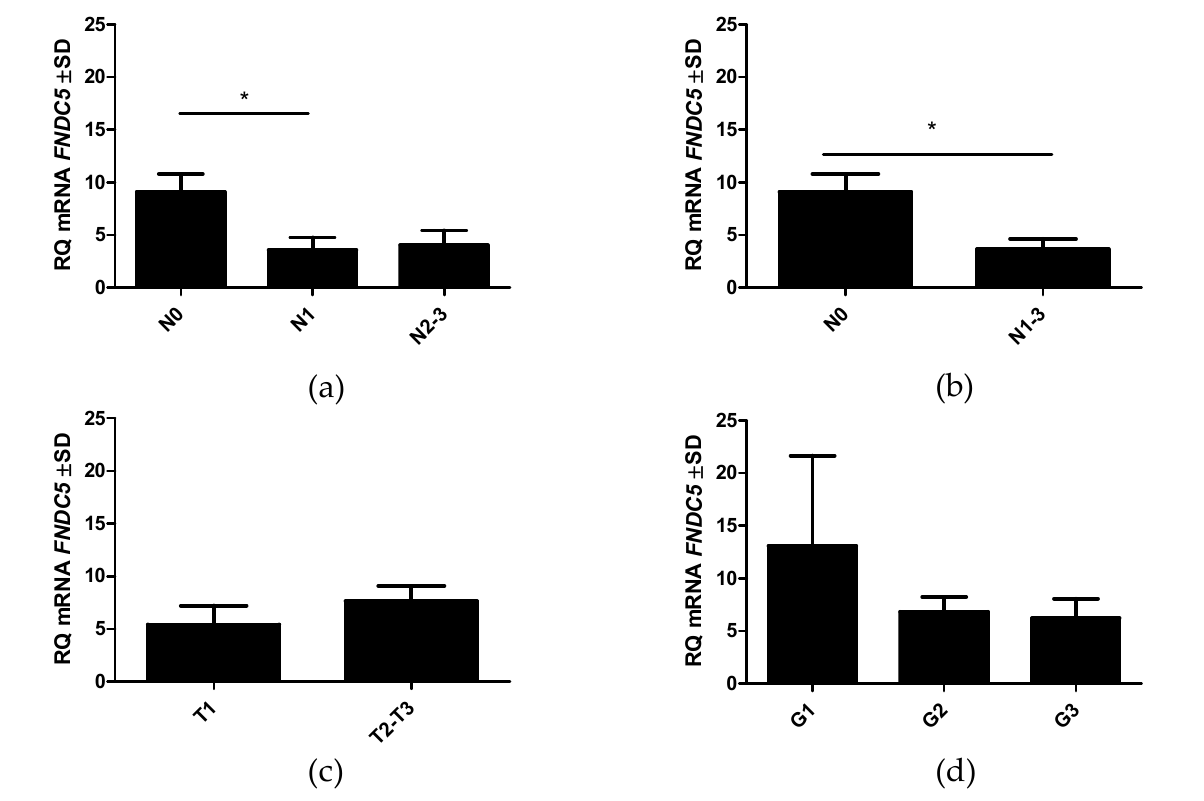
Figure 7. FNDC5 gene expression in breast cancer (BC) cells according to the N status ( a , b ), tumor size ( c ), and malignancy grade ( d ). * p < 0.05.